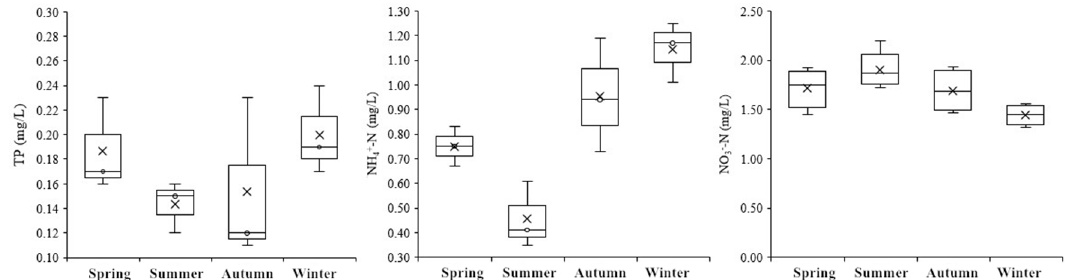
Figure 4. Seasonal variation in pollutant concentrations in Taoxi Creek.